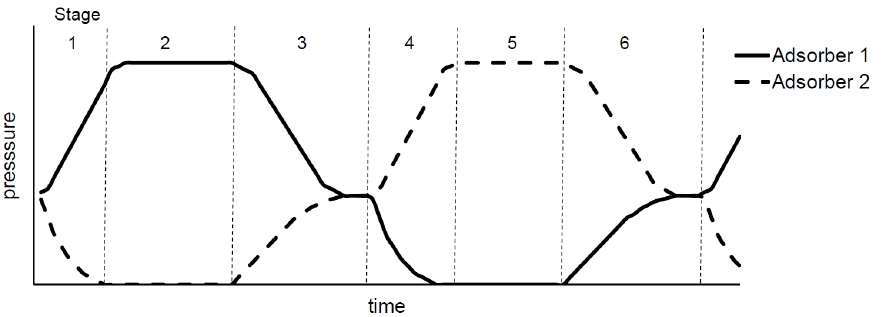
Figure 2. The pressure cycle in adsorptive oxygen generator. 1, 4—air compression/bed regeneration; 2, 5—oxygen transfer to the oxygen tank; 3, 6—pressure